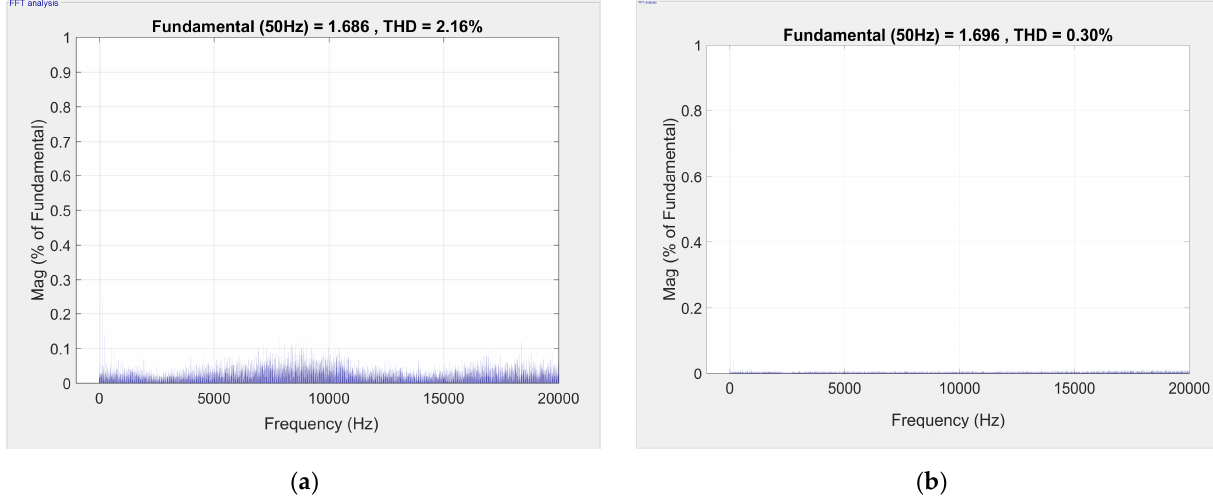
Figure 16. The load current spectrum of FS-PDCC controlled three-phase VSI: ( a ) T s = 20 μs; ( b ) T s = 5 μs. Comparison with Conventional Control Techniques